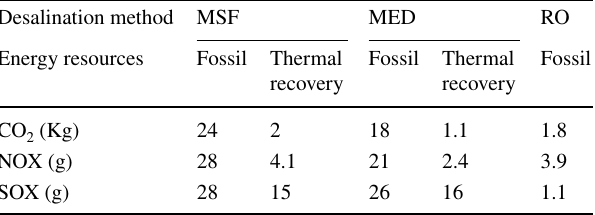
Contributions of air pollutants produced by different desalt- ing